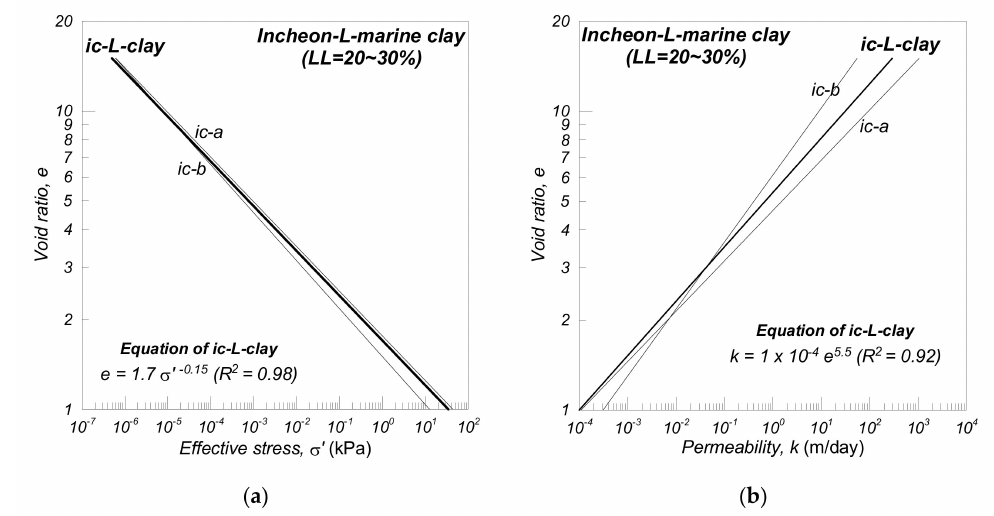
Figure 14. Constitutive relationship of Incheon L marine clay (ic-L-clay): ( a ) void ratio vs. e ff ective stress; ( b ) void ratio vs. permeability.